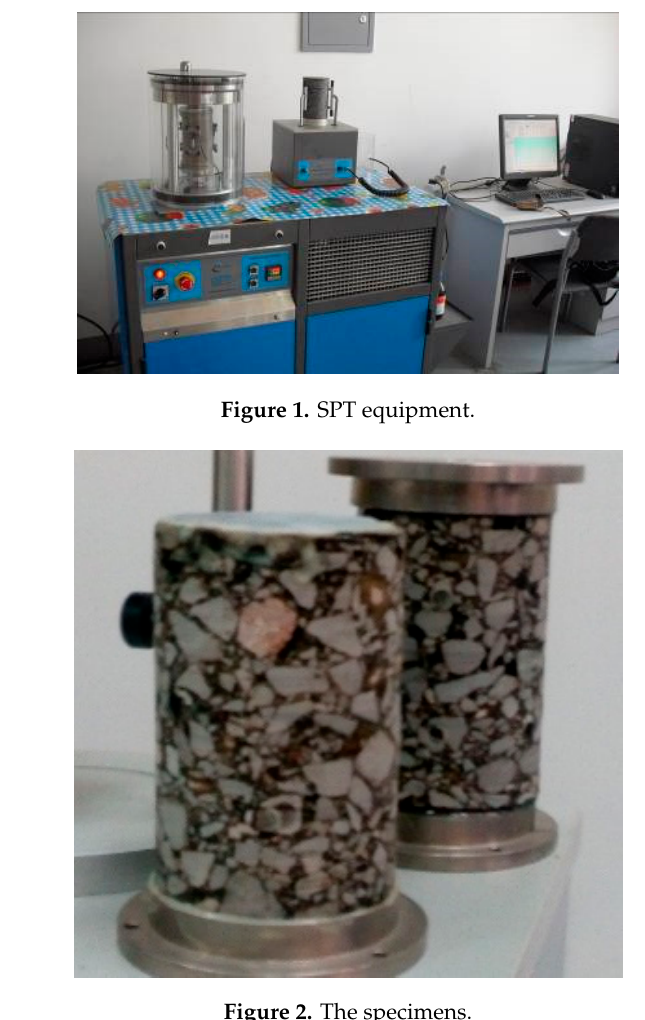
Figure 2. The specimens.